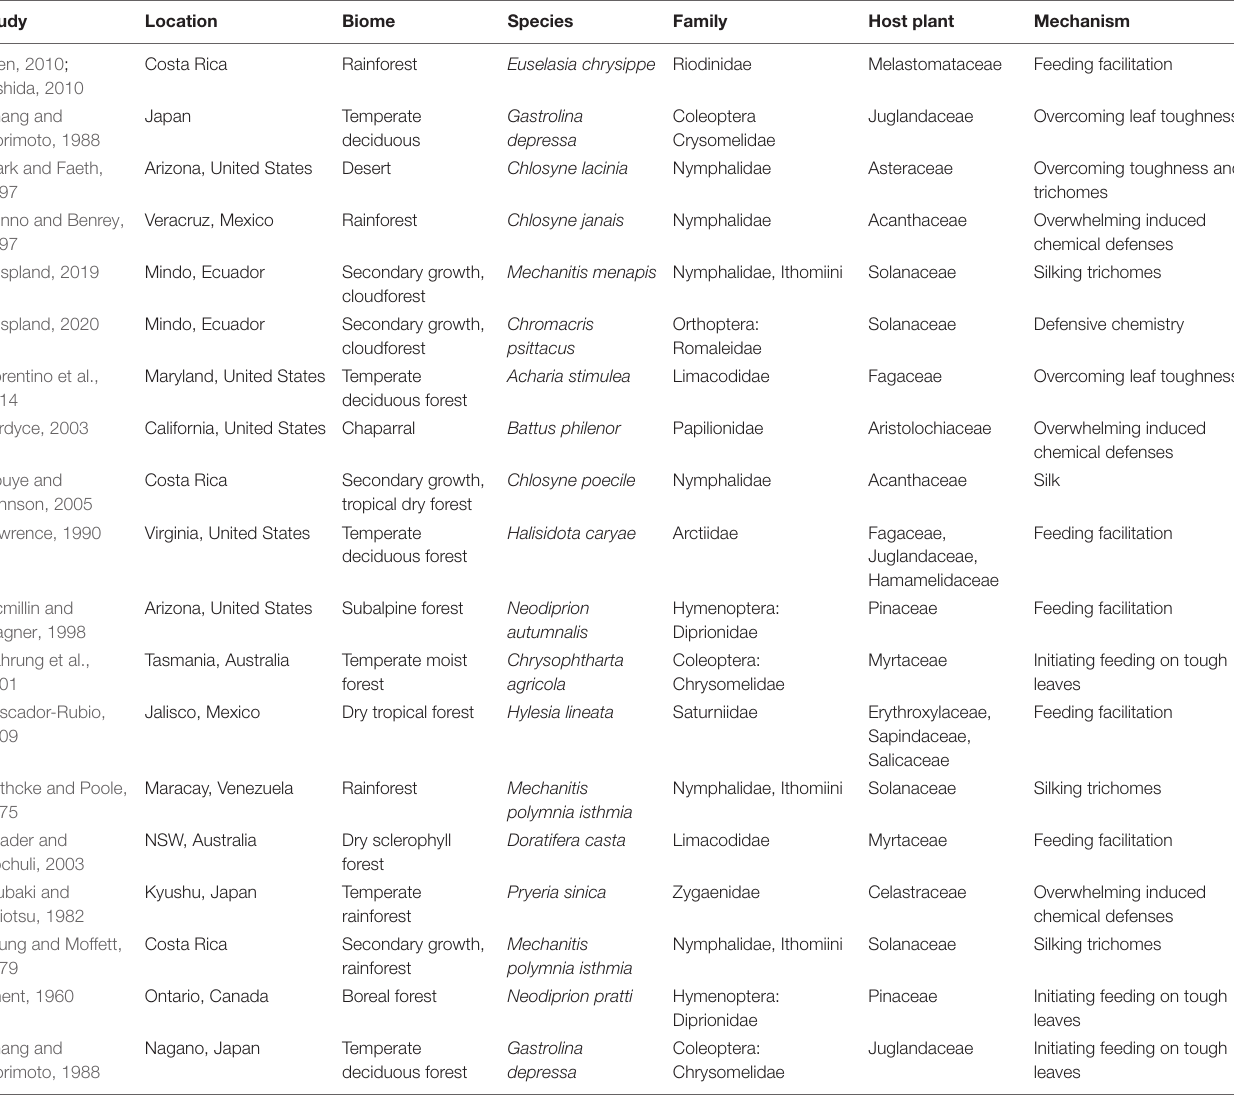
TABLE 2 | List of studies demonstrating social facilitation of feeding, indicating the location and biome in which the study was conducted, the species and family of insect involved, the family of the plant on which assays were conducted and the reported